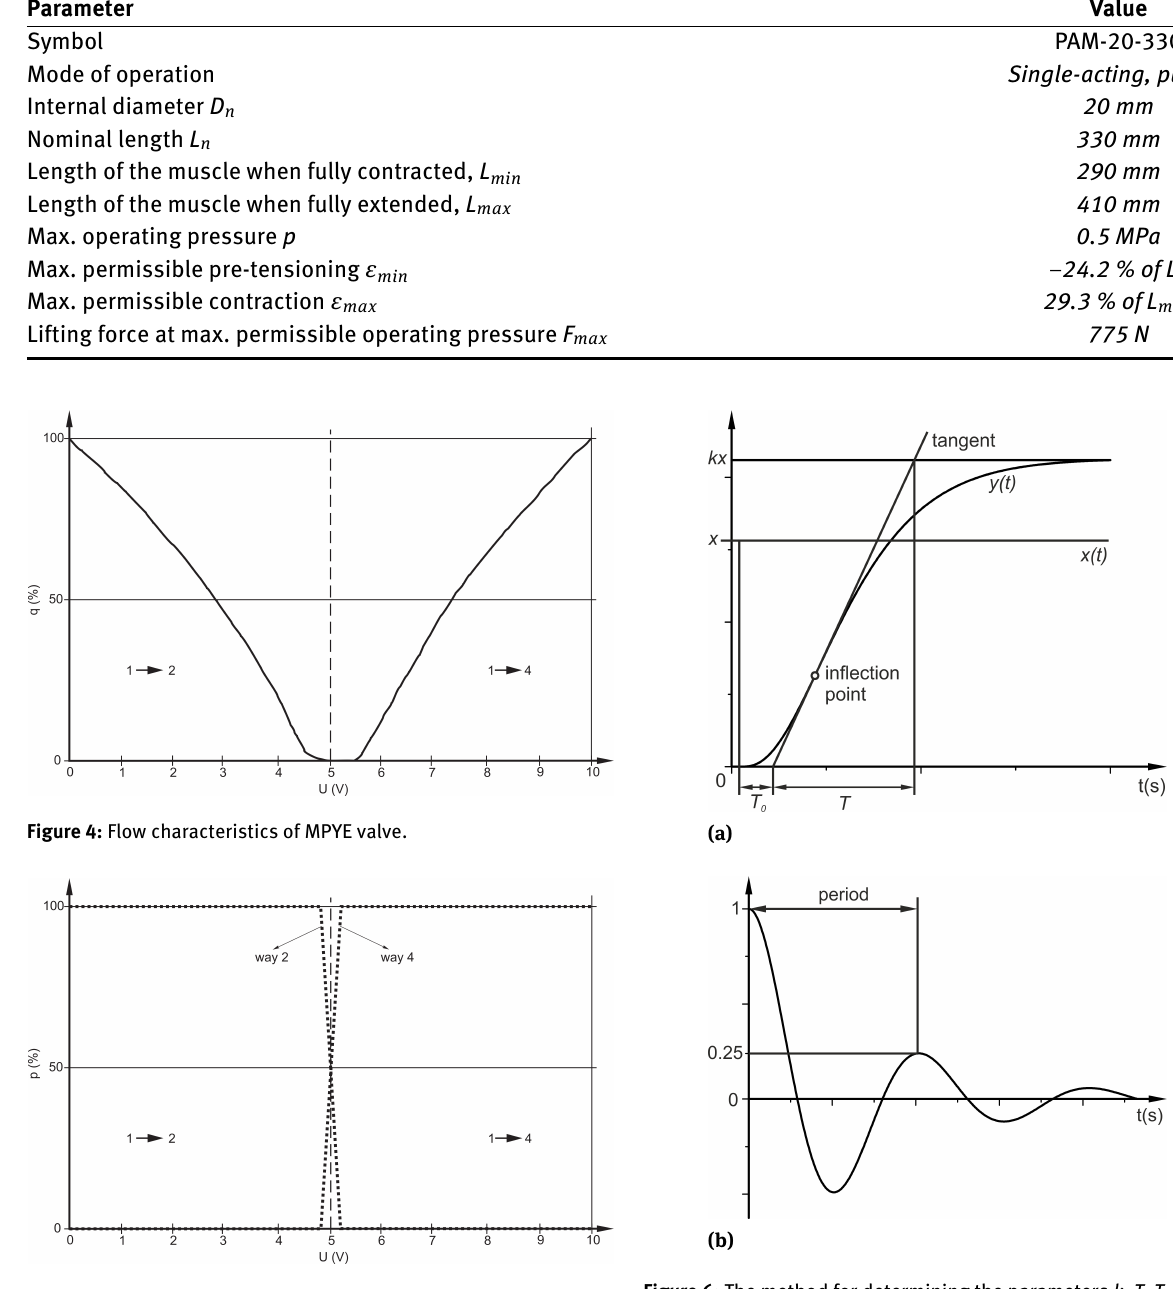
Figure 5: Pressure characteristics of MPYE valve. Figure 6: The method for determining the parameters k , T , T 0